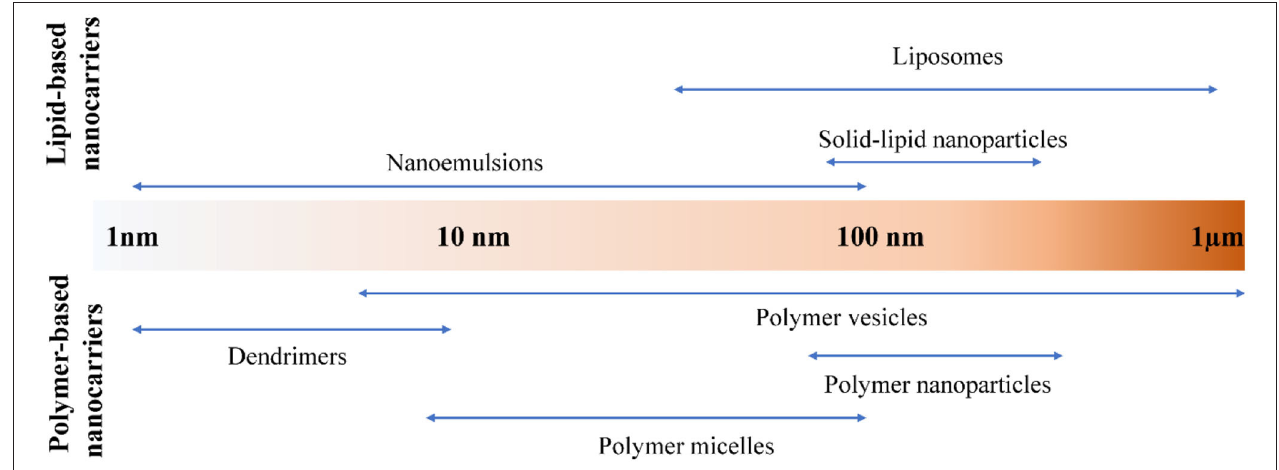
FIGURE 1 | Lipid and polymer-based nanocarrier